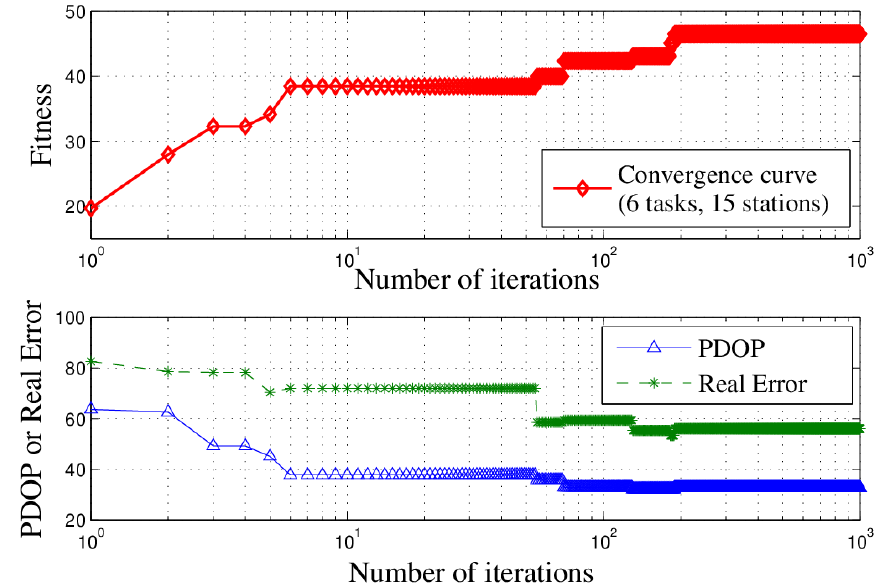
Figure 14. Accuracy over iterations (with six tasks and 15 stations).